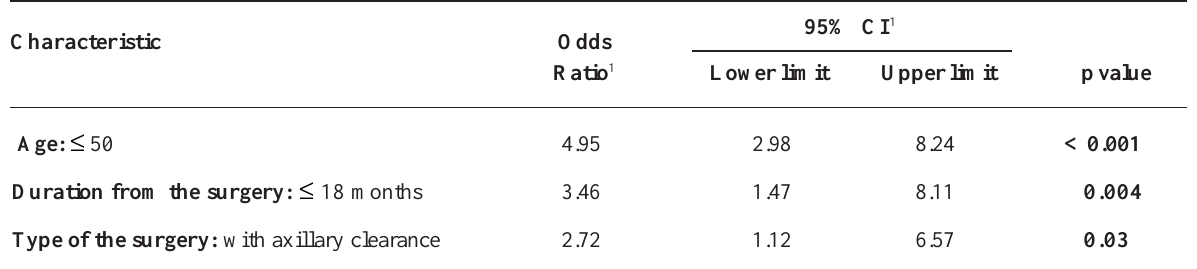
Table 4. Multivariate analysis to determine the most important factor associated with PMPS